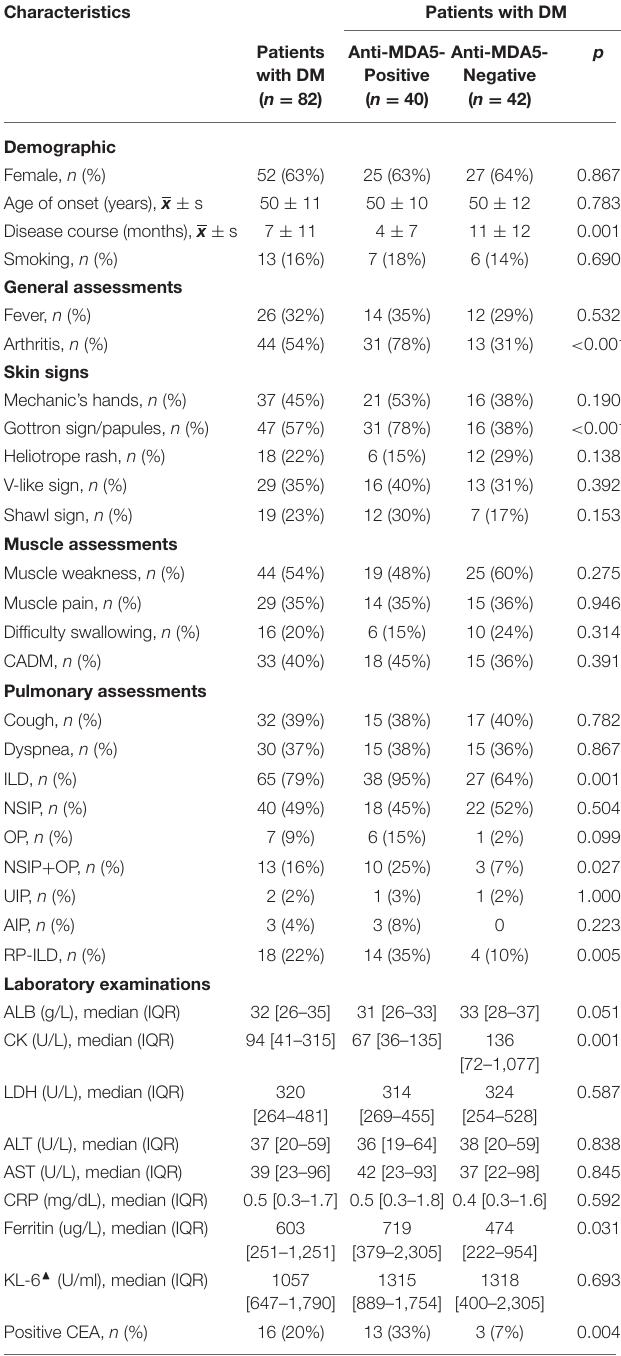
TABLE 1 | Clinical characteristics of 82 patients with DM and the subgroups based on the